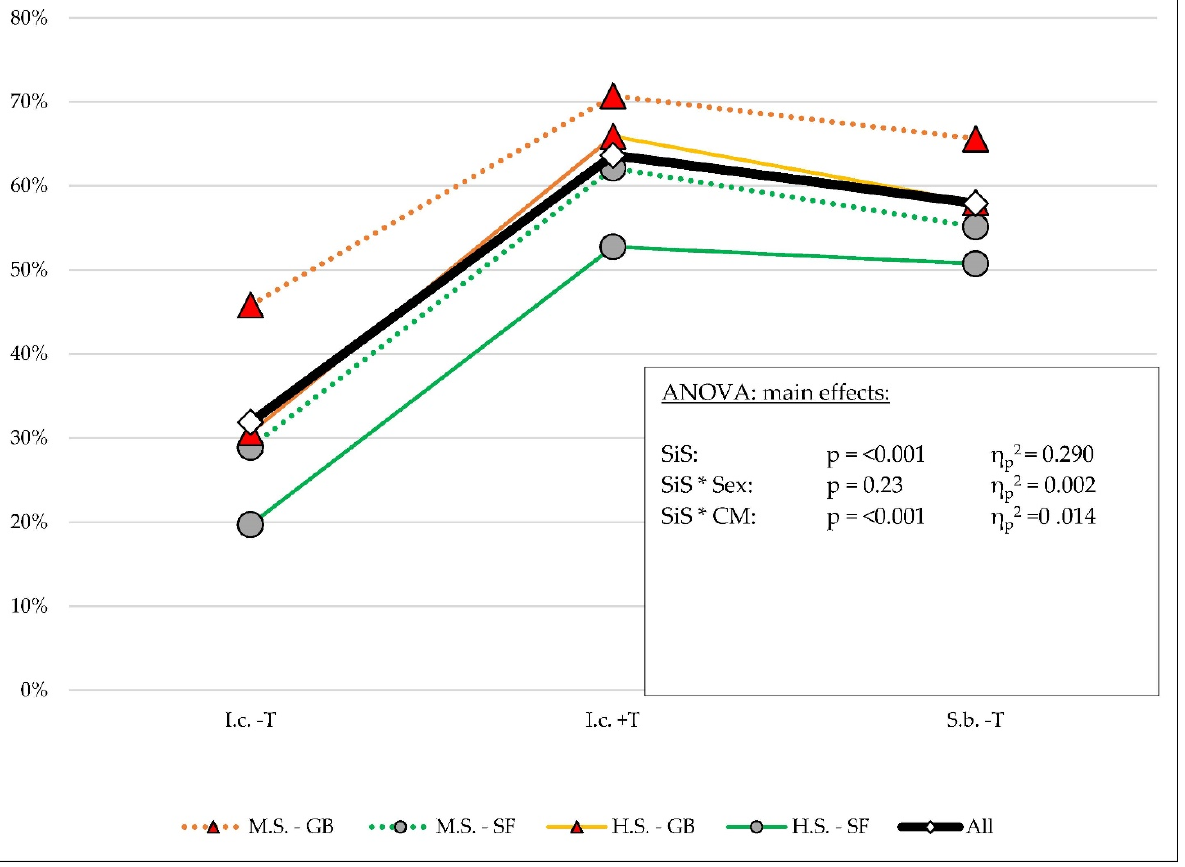
Figure 2. Percentage of self ‐ estimated time of correct mask wearing with respect to the main effects in different situations in the schools.